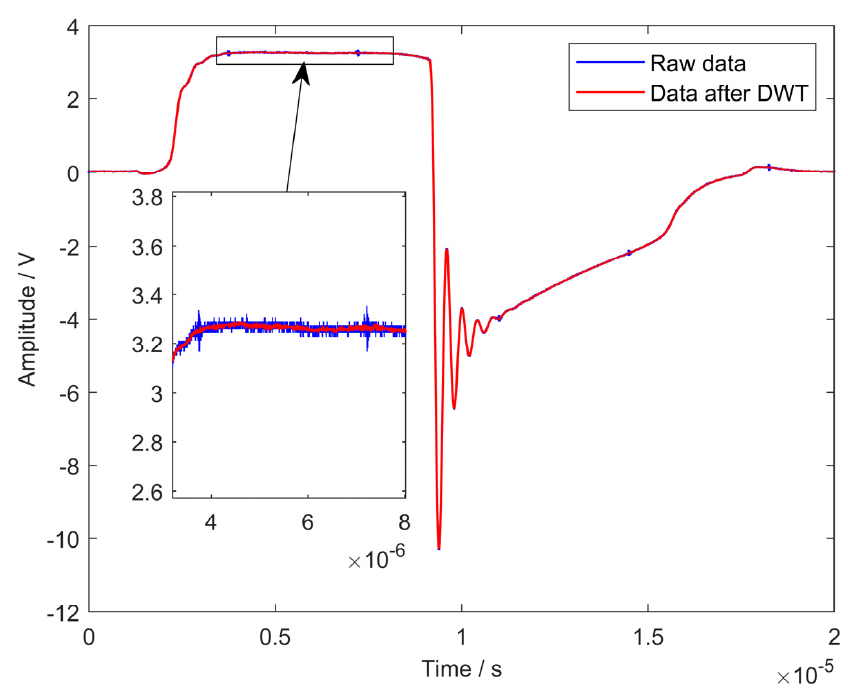
Figure 4. Comparison of the signals before and after wavelet transformed.